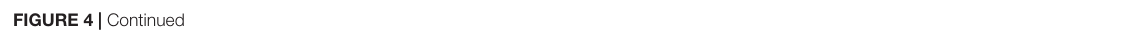
FIGURE 4 | Continued longest neurite. (B) Representative Western blot assays performed with cell lysates obtained from differentiated PC12 cells transduced with shScramble or shCREB3L2 I and blotted against CREB3L2 (detecting the N-terminal domain or cleaved fragment) and α -tubulin. Quantification of the total neurite length (C) and the longest neurite (D) . (E) Schematic representation of the Sholl analysis performed in the cells. (F) Left panel: Representative images of differentiated PC12 cells transduced with shScramble or shCREB3L2 I and fixed at 6 days post NGF induction. Acquired images were inverted for morphometric analysis. Right panel: Quantification of the number of intersections crossing the shells. (G) Representative images of differentiated PC12 cells transfected with control EGFP or CREB3L2FL plasmids and fixed at 2 and 4 days post NGF induction. Quantification of the total neurite length (H) and the longest neurite (I) . (J) 3D projection of GM130 immunostaining in cells transduced with shCREB3L2 I or transfected with control EGFP or CREB3L2 FL plasmids. Arrowheads indicate punctate structures labeled with GM130. (K) Left panel: Representative images of differentiated PC12 cells transfected with shScramble or shCREB3L2 I and fixed at 3 days post NGF induction and immunostained for Rab5. Fire-LUTs are shown to clearly visualize IF levels. Right panel: Quantification of Rab5 fluorescence intensity normalized with the control. (L) Left panel: Representative images of differentiated PC12 cells transfected with control-EGFP or CREB3L2 FL plasmids and fixed at 4 days post NGF induction and immunostained for Rab5. Fire-LUTs are shown to clearly visualize IF levels. Right panel: Quantification of Rab5 fluorescence intensity normalized with the control. Bars represent the mean ± SEM of three independent experiments carried out in triplicates, and a total of 50 cells were analyzed. Statistical data analysis was performed, using the Student’s T -test, considering statistically significant a value of p < 0.05 ( ∗ p < 0.05, ∗∗ p < 0.01; ∗∗∗ p < 0.001). Scale bars